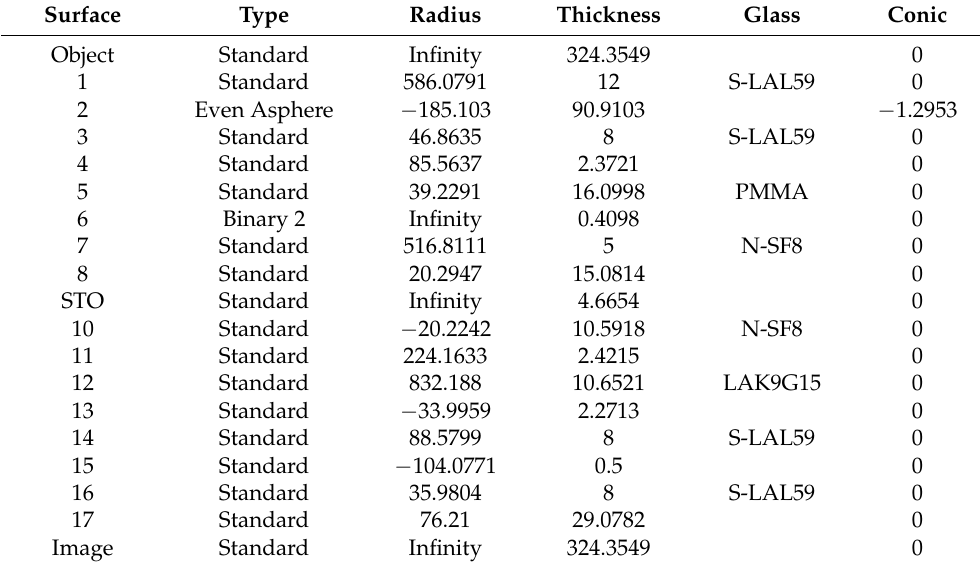
Figure 2. Layout of the refractive/diffractive projection lens system for DMD-based maskless lithography. Table 2. Lens data of hybrid projection lens system.